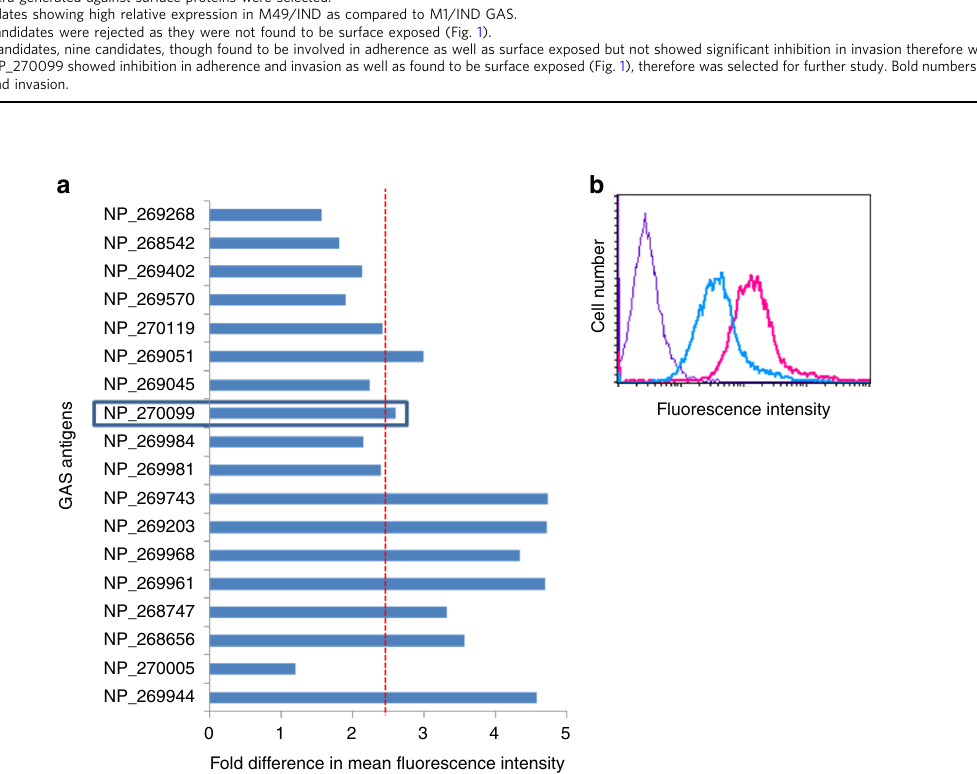
Fig. 1 Surface localization of potential vaccine candidates on GAS M49 surface. a Surface exposure analysis of 18 selected candidates. GAS M49 cells were incubated with protein-speci fi c polyclonal antibodies and surface localization was analyzed by fl ow cytometry using FITC-conjugated secondary goat anti-mouse IgG. Mean fl uorescence intensity (MFI) obtained for each immunized serum (I) was normalized with the MFI of preimmunized sera (PI) to measure the fold difference. Serum candidates showing >2.4-fold difference in MFI (represented by red dotted line) were considered signi fi cant. b Histogram depicting SPy_2191 surface exposure. In the overlay diagram, purple line represents control M49 GAS cells without antisera, blue line represents cells with preimmunized antisera and red line represents cells incubated with SPy_2191 antisera. Experiment was repeated two times and data shown here are a representative